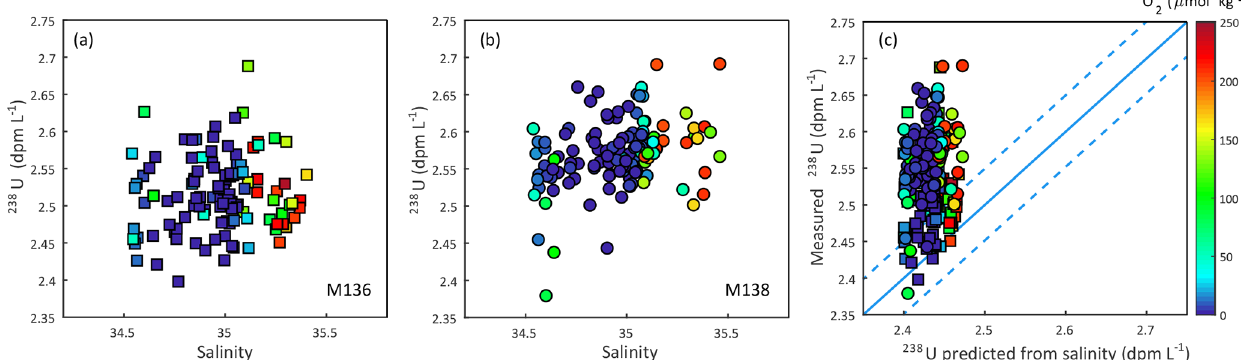
Figure 7. Cross plots of measured 238 U activities vs. salinity for M136 (a) and M138 (b) , showing poor linear relationship between 238 U and salinity. Panel (c) shows a direct comparison between measured and salinity-based 238 U to further highlight the large difference between the two. The solid blue line indicates the 1:1 ratio between measured and projected 238 U. Dashed blue lines indicate the ± errors reported in Owens et al. (2011). Error bars for measured 238 U activities are smaller than